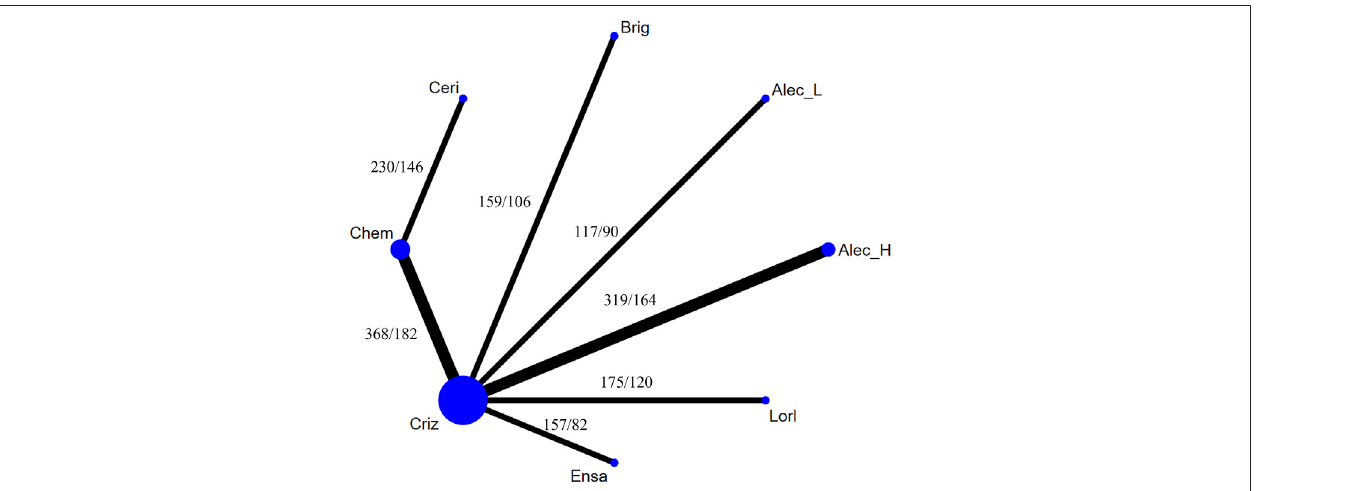
FIGURE 4 | Network constructions for comparisons in progression-free survival of the never-smoker group or smoker group. Chem, chemotherapy; Criz, crizotinib; Brig, brigatinib; Ceri, ceritinib; Ensa, ensartinib; Alec_L, low-dose alectinib; Alec_H, high-dose alectinib; Lorl, lorlatinib. The “ number 1/number 2 ” listed in the upper left of each comparison means that number 1 is the number of never-smokers and number 2 is the number of smokers in each comparison.